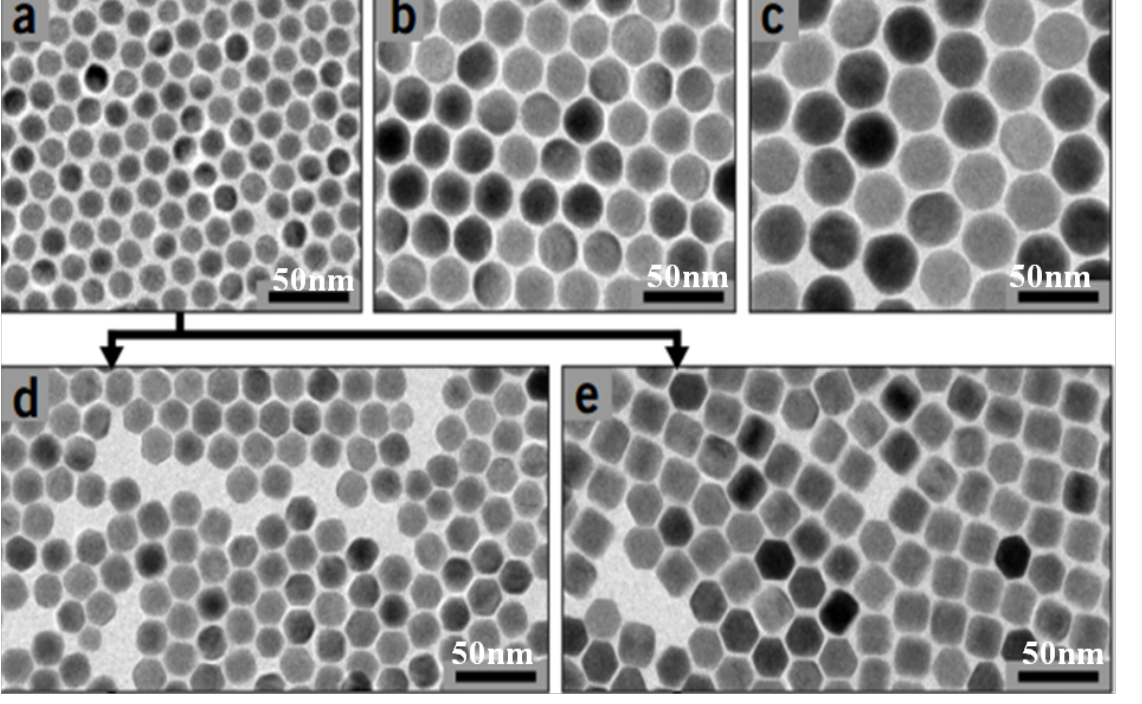
Figure 3: Size-tuning of the NaGdF 4 nanocrystals. a-c) TEM images of NaGdF 4 :Yb/Tm nanocrystals prepared by adding 3.3, 3.1 and 2.7ml of NH 4 F/methanol solutions, respectively. d, e) TEM images of NaGdF 4 :Yb/Tm@NaGdF 4 :Tb core-shell nanocrystals prepared by adding 50 and 25 mg of 15nm core particles, respectively